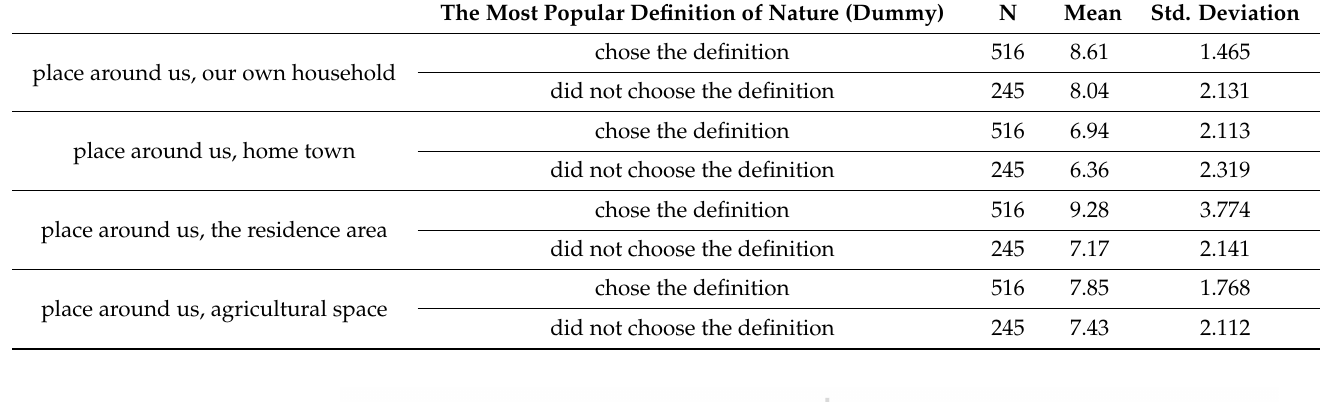
Table 2. Statistical indicators related to the perception of nature through 4 permanent aspects of respondents’ daily lives.